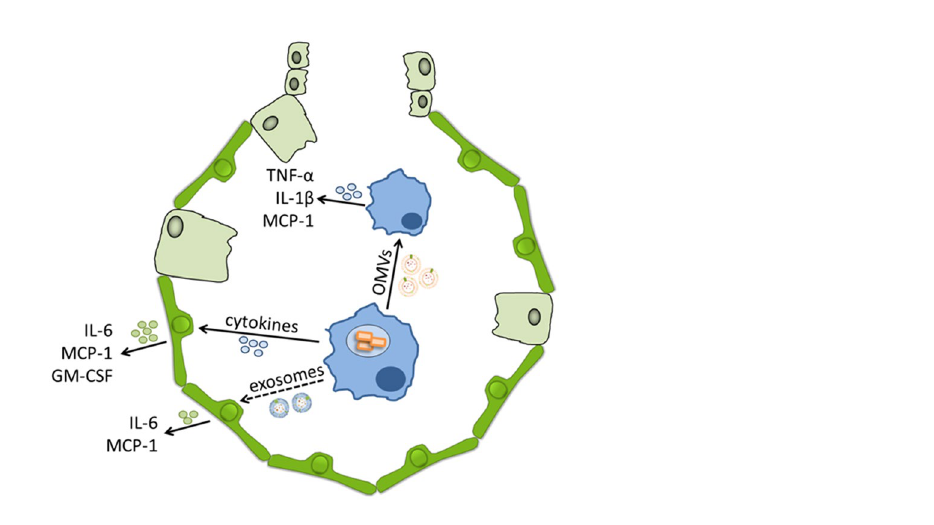
Figure 8. Differential microvesicles signalling in L . pneumophila infection of macrophages. The infection of macrophage-like THP-1 cells with L . pneumophila induces the release of pro-inflammatory cytokines and EVs, eukaryotic exosomes and prokaryotic OMVs. While alveolar epithelial cells mostly respond to the cytokines with a pro-inflammatory response and to a weaker extent to the exosomes, macrophages respond to the released EVs. Here, the bacterial OMVs carrying the LPS are the main stimulating